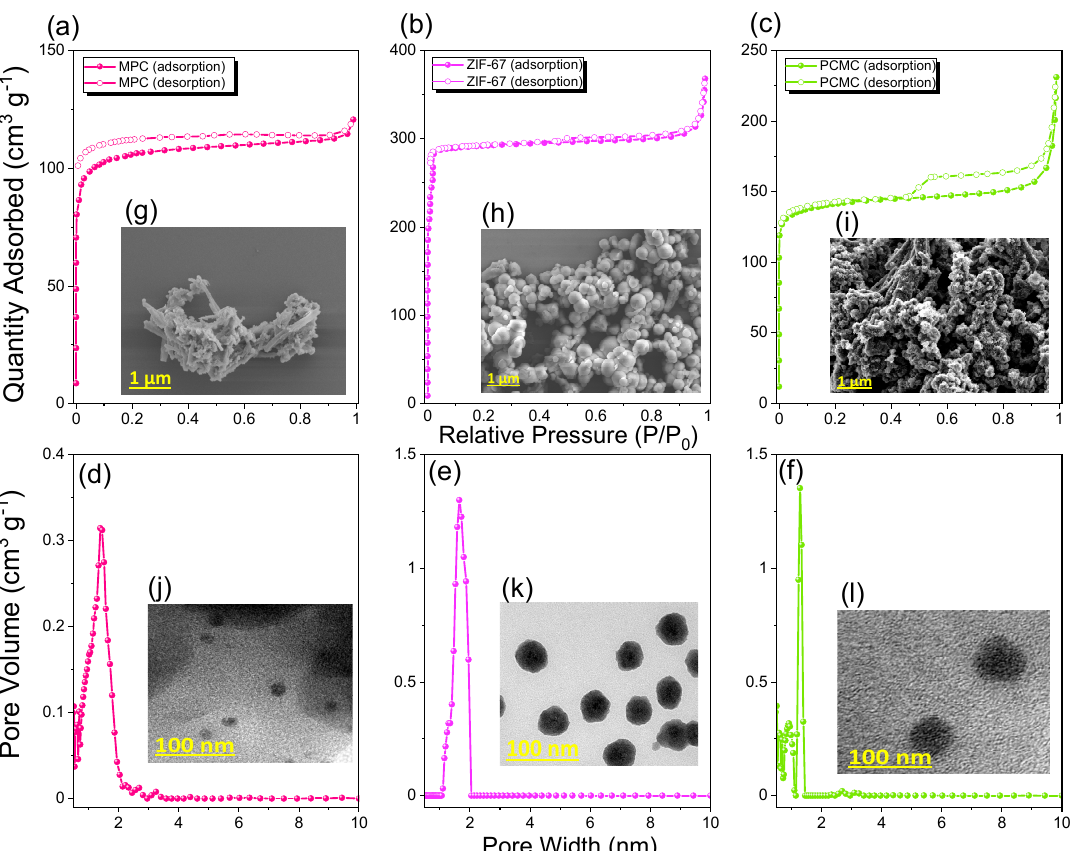
Figure 7. ( a – c ) N 2 adsorption/desorption isotherms of ( a ) MPC, ( b ) ZIF-67, and ( c ) PCMC. Pore size distribution of ( d ) MPC, ( e ) ZIF-76, and ( f ) PCMC. ( g – i ) SEM and ( j – l ) TEM images of ( g , j ) MCP, ( h , k ) ZIF-67, and ( i , l ) PCMC.